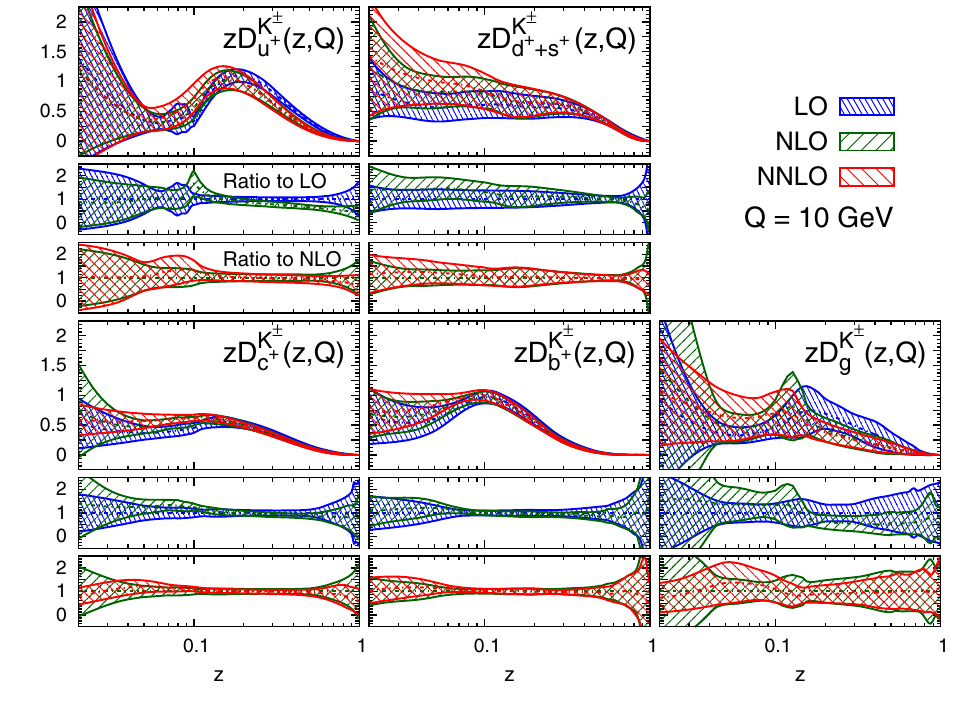
Fig. 11 Same as Fig. 9 but for the sum of protons and antiprotons, p / ¯